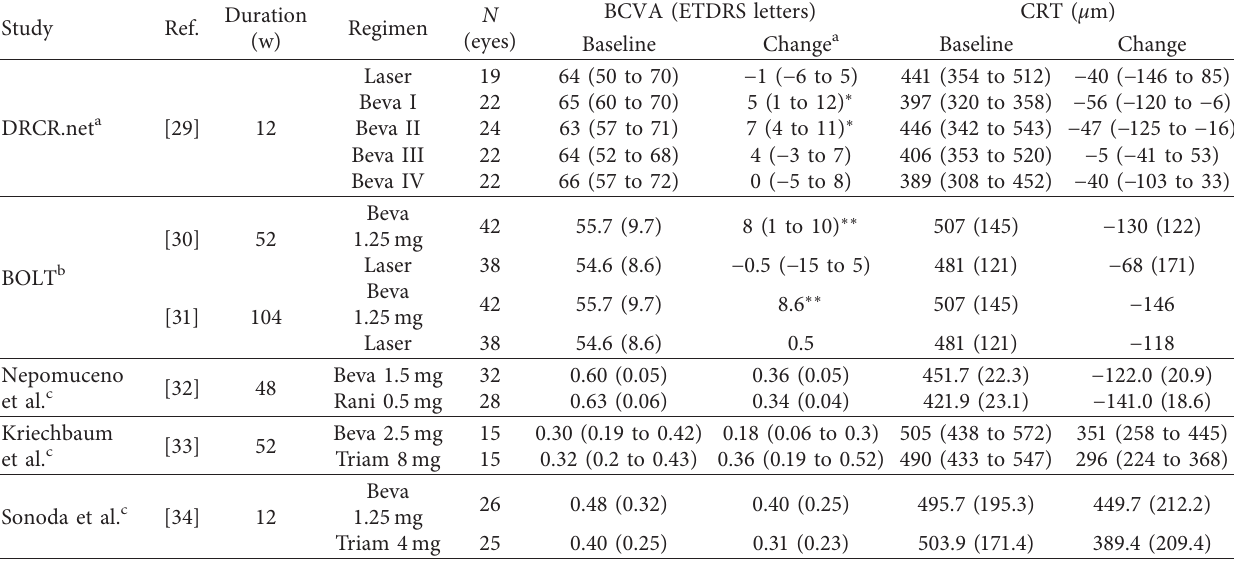
Table 1: Overview of the functional and anatomic results of bevacizumab.